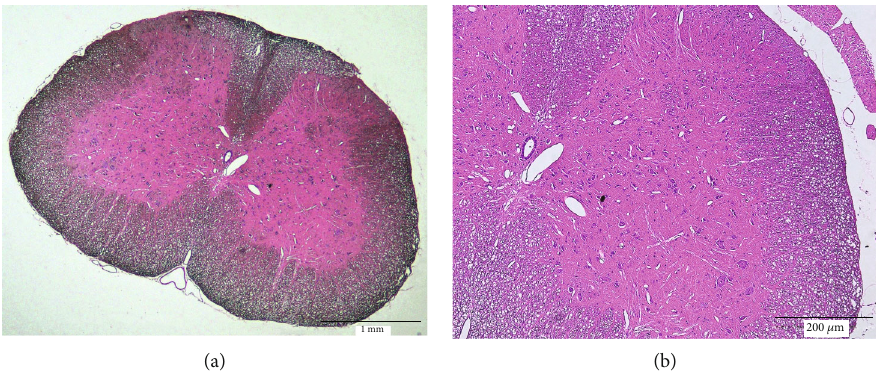
Figure 3: H&E staining showed that LIFU was safe for stimulating the spinal cord ((a) × 40, scale bar = 1 mm ; (b) × 100, scalebar = 200 μ m ) L4 – L5 section of the spinal cord, showing no edema, hemorrhage, or cell